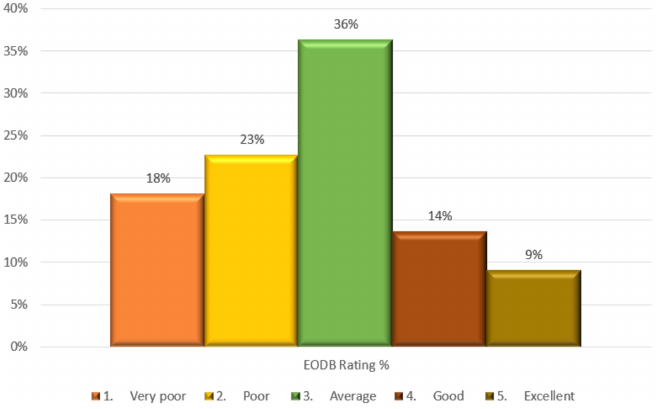
Figure 3. Rating of ease of doing